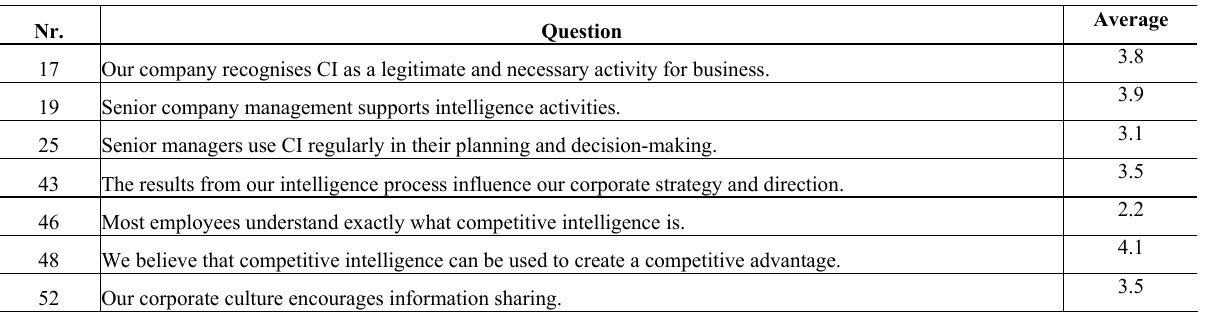
Table 13: Results of the awareness and culture questions Nr.